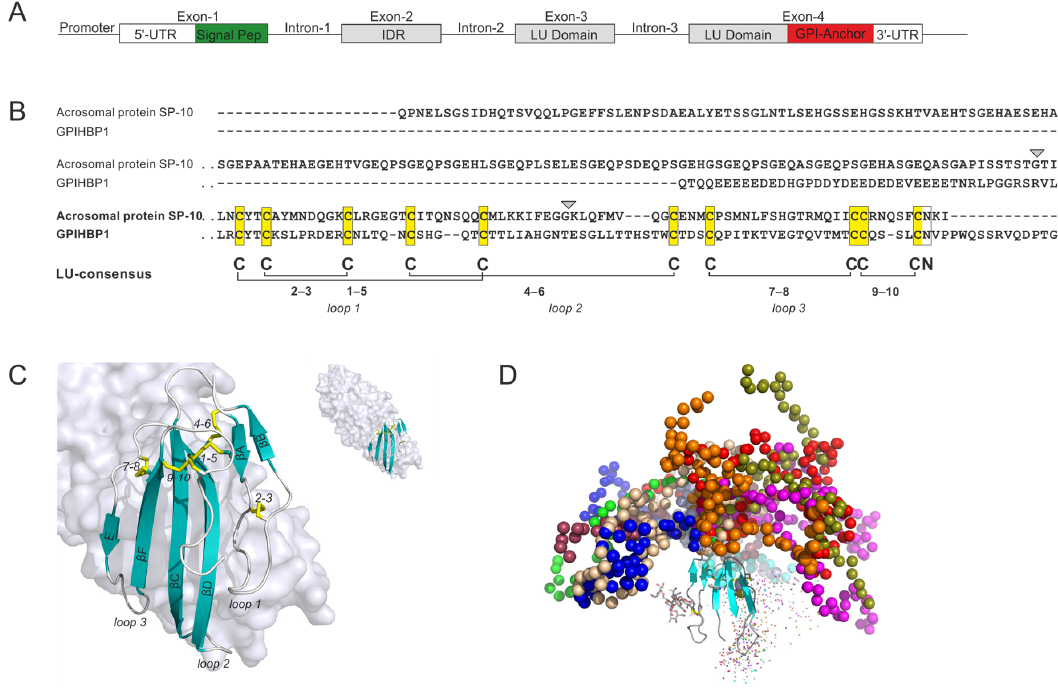
Figure 4. Gene structure, sequence, and three-dimensional structure of GPIHBP1: ( A ) The gene organization of GPIHBP1, containing an additional exon ( IDR ) in front of the traditional exon-set encoding the LU domain. ( B ) A sequence alignment of the LU domains of GPIHBP1 and SP-10, the only two proteins in the human genome with an extra exon encoding an intrinsically disordered N-terminal segment. Gray arrowheads highlight the positions of introns 2 and 3. The length of the IDR extension of SP-10 varies considerably due to alternative splicing events in exon 2 [73]. ( C ) The crystal structure of GPIHBP1 bound to the lipoprotein lipase (LPL). The gray surface represents LPL, whereas the LU domain of GPIHBP1 is shown as a cartoon representation, using the same color-coding as in the earlier figures [PDB 6E7K [7]]. Only the LU domain is defined in the crystal structure; as the acidic intrinsically disordered domain at the amino terminus is not well defined in the electron density map and most likely forms a fuzzy complex with LPL. ( D ) A model of GPIHBP1 based on small-angle X-ray scattering, with the likely spatial distribution of the acidic disordered extension illustrated with colored beads, each color representing one likely spatial distribution. Reproduced with permission from Kristensen et al.